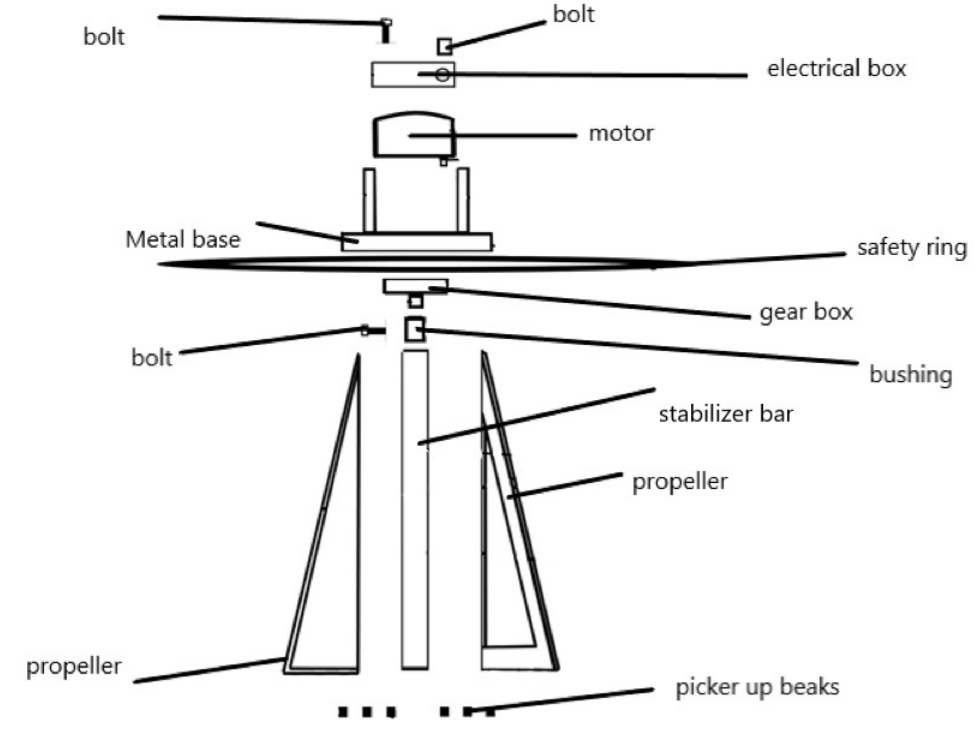
Figure 1. Side view with separate